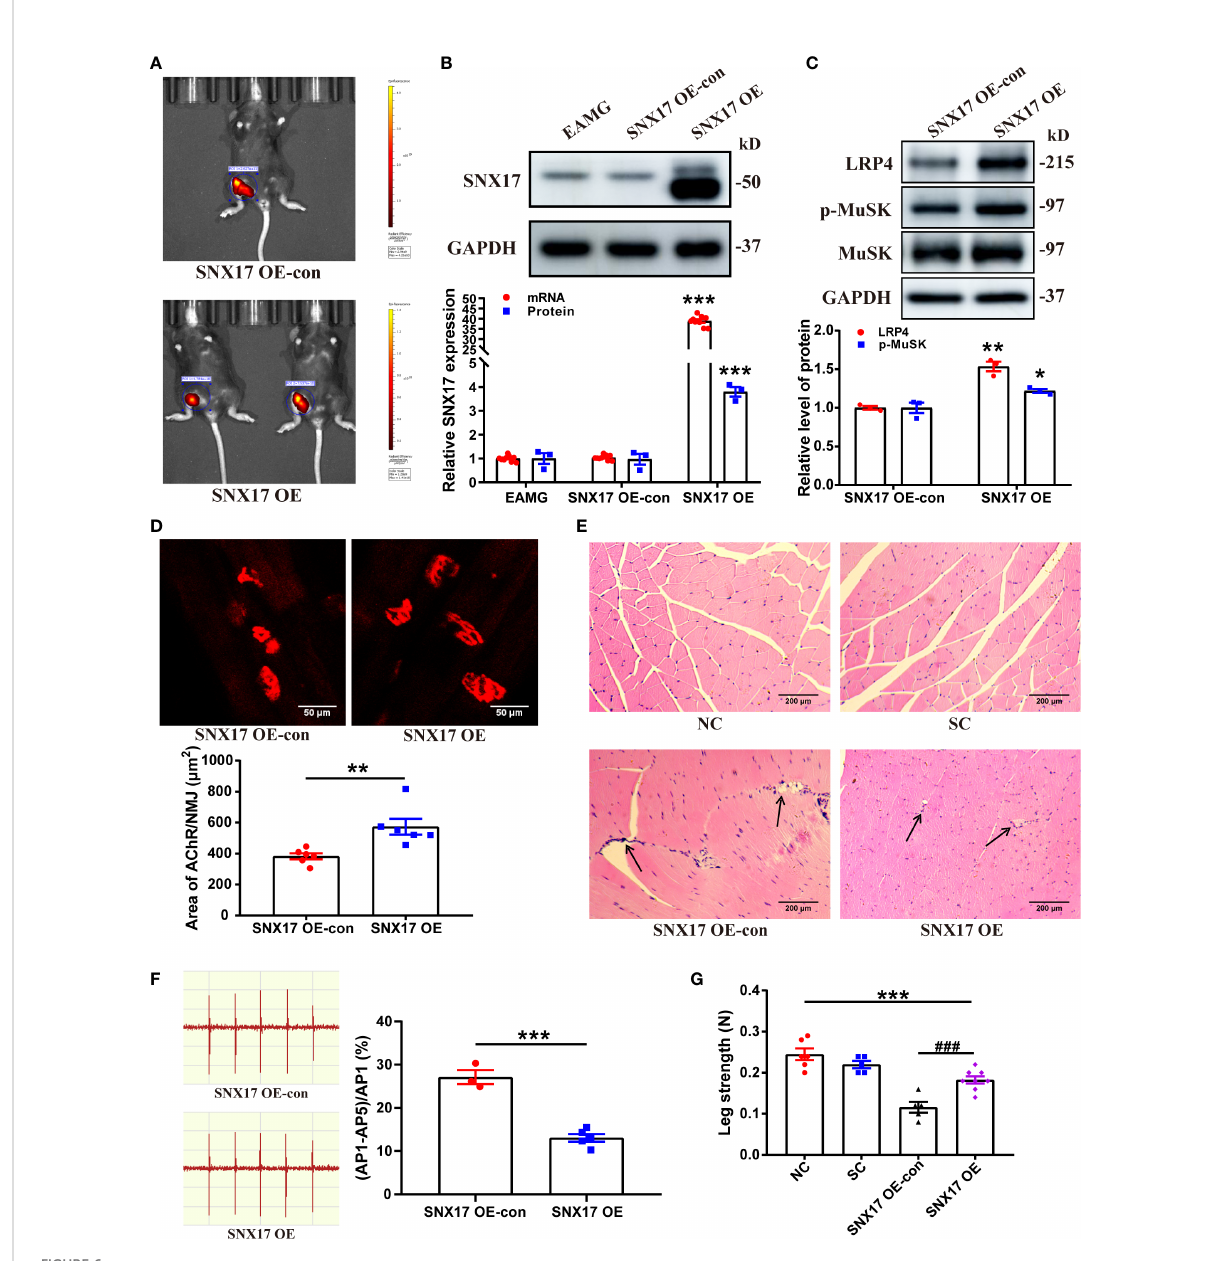
FIGURE 6 SNX17 overexpression increased LRP4 expression and MuSK phosphorylation in the gastrocnemius muscle of EAMG mice and improved AChR morphology at the NMJ and leg weakness. (A) Small-animal live imaging of EAMG mice infected with AAV2/9-ZsGreen and AAV2/9-CMV-m- SNX17-3x fl ag-ZsGreen for 21 days in the gastrocnemius muscle of the right leg. (B) Western blotting and qPCR analyses of SNX17 protein (n = 3/ group) and mRNA (n = 9/group) in the gastrocnemius muscle tissue. (C) Western blotting analyses of LRP4, MuSK, and p-MuSK expression in the gastrocnemius muscle tissue. n = 3/group. (D) AChR (red) at the NMJ of the gastrocnemius fi laments was labeled with R-BTX and the area of AChRs was quanti fi ed with ImageJ. n = 6/group; Scale bar = 50 m m. (E) Hematoxylin and eosin-stained pathological analyses of cross-sections of the gastrocnemius muscle fi bers of mice in each group. Black arrows indicate muscle fi ber atrophy, rupture, or in fl ammatory cell in fi ltration. Scale bar = 200 m m. (F) EMG of the gastrocnemius muscle was assessed using low-frequency RNS. The attenuation rate of the fi fth amplitude of EMG compared with the fi rst amplitude was calculated. SNX17 OE-con: n = 3; SNX17 OE: n = 5. (G) Bar dynamometer measurement of the right leg strength of mice in each group. NC: n = 6; SC: n = 5; SNX17 KD-con: n = 5; SNX17 KD: n = 8. All data are presented as mean ± SEM. * P <0.05, ** P <0.01, *** P <0.001, ### P<0.001. AChR, acetylcholine receptor; EAMG, experimental autoimmune myasthenia gravis; LRP4, low-density lipoprotein receptor-related protein 4; MuSK, muscle-speci fi c receptor tyrosine kinase; NMJ, neuromuscular junction; R-BTX, rhodamine-labeled bungarotoxin; RNS, repetitive nerve stimulation; SC, solvent control; SEM, Standard Error of Mean; SNX17, sorting nexin